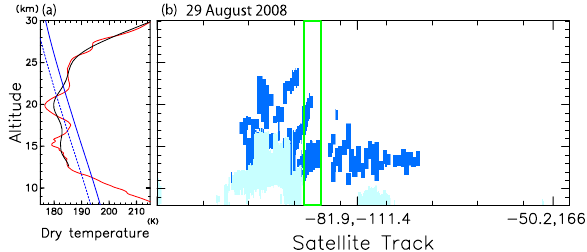
Fig. 7. (a) Original (red) and smoothed (black) profiles of dry tem- perature at 82.8 ◦ W, 80.2 ◦ E on 29 August 2008 from COSMIC. A smoothing was made using a lowpass filter with a cutoff length of 6km. A blue solid (broken) line indicates T NAT ( T STS ) . (b) A horizontal and height section of feature type from CALIPSO on 29 August 2008. Blue (light blue) areas indicate “stratospheric” cloud (tropospheric “cloud”) layers. A green rectangle indicates the re- gion of the dry temperature profile show in (a) .